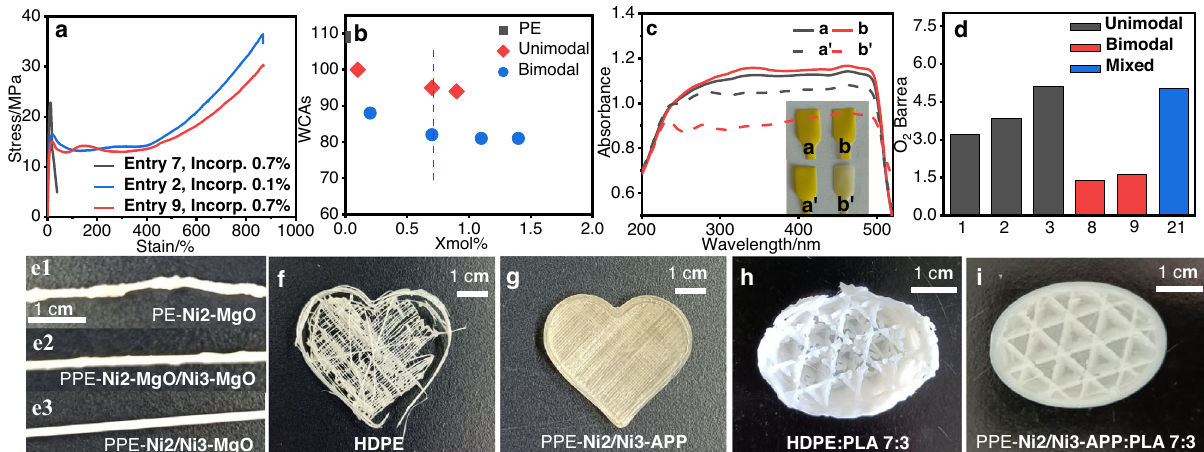
Fig. 6 | Polar properties and 3D printing of polar bimodal polyethylene. a Tensile curves of samples from Table 1, Entry 7 (Incorp. 0.7%), Entry 2 (Incorp. 0.1%), and Entry 9 (Incorp. 0.7%). b Water contact angles of ethylene/ tert -butyl acrylate copolymers from Table 1. Unimodal: unimodal polar polyethylene from Table1,Entry1,Entry2,andEntry7.Bimodal:polarbimodalpolyethyleneprepared by co-anchored catalyst from Table 1, Entries 8 – 11. c UV-vis absorption spectra of thedyedpolymerproductsbeforeandafteracetonewash(aanda ’ :Table1,Entry9. b and b ’ : Table 1, Entry 7). d Oxygen permeability coef fi cient of polyethylene samplesfrom Table1 at25°C. The abscissarepresents the relative entryin Table1.